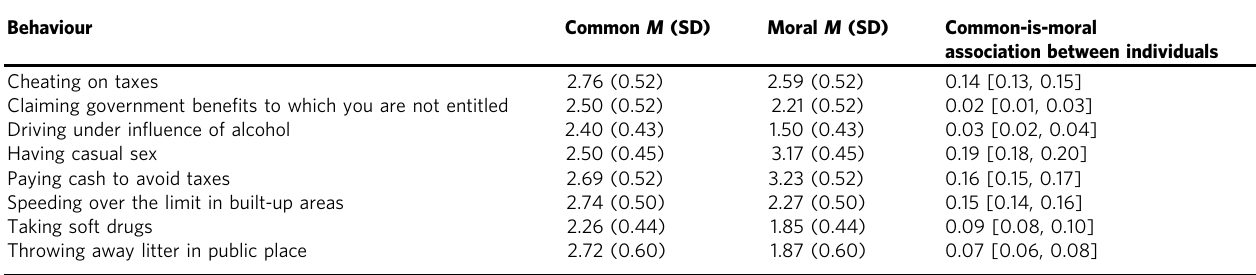
Table 1 Descriptive statistics for perceptions of how common and how moral eight questionable behaviours are, and the common-is-moral association.